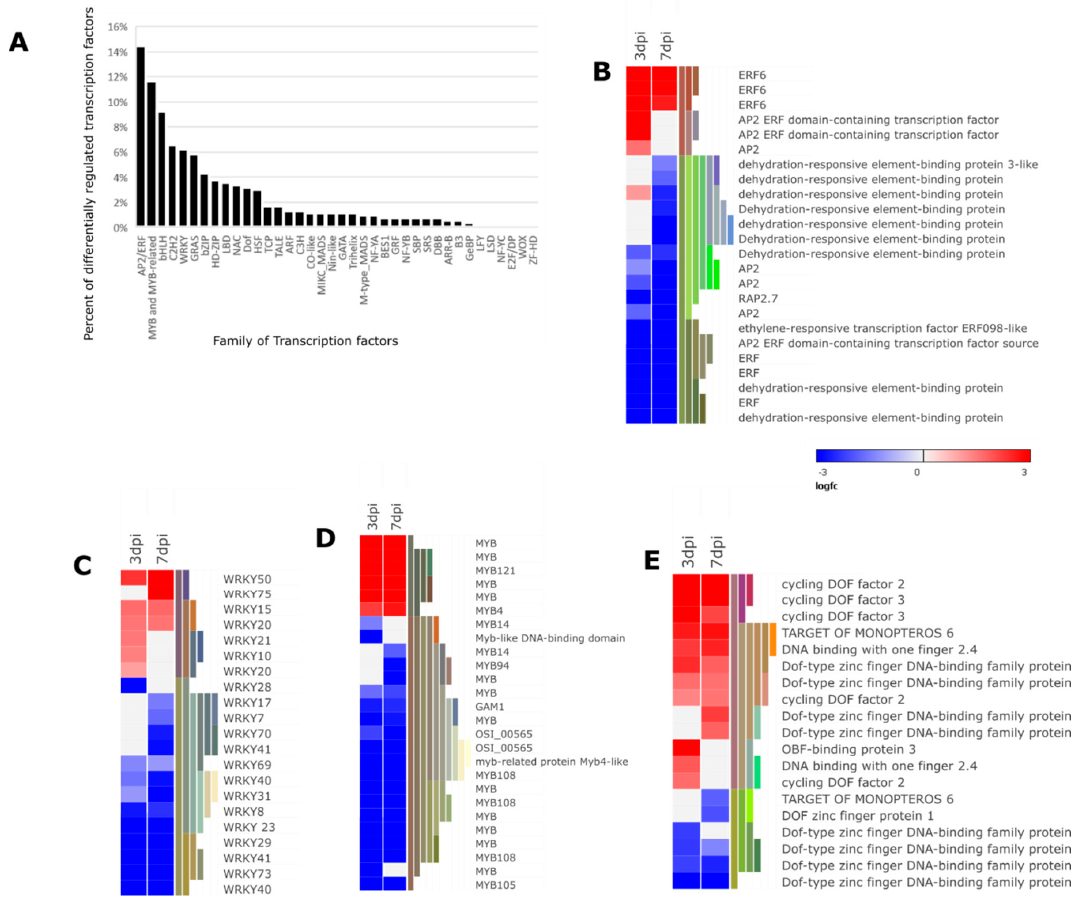
Figure 7. Heat map representation of di ff erential regulation of transcription factors. ( A ) Represents various families of TFs under the regulation of Meloidogyne javanica . ( B ) AP2 / ERF family. ( C ) WRKY family. ( D ) MYB family. ( E ) DOF family (The heat map represents a subset of the di ff erentially expressed family of TFs. Refer to supporting information for all transcription factors family displaying di ff erential expression).